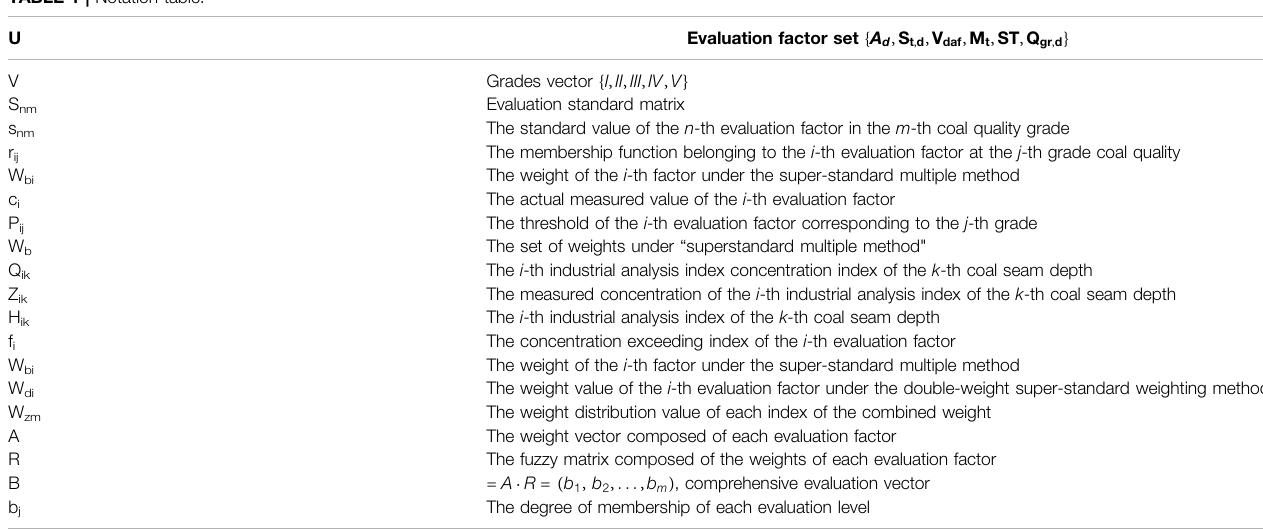
TABLE 1 | Notation